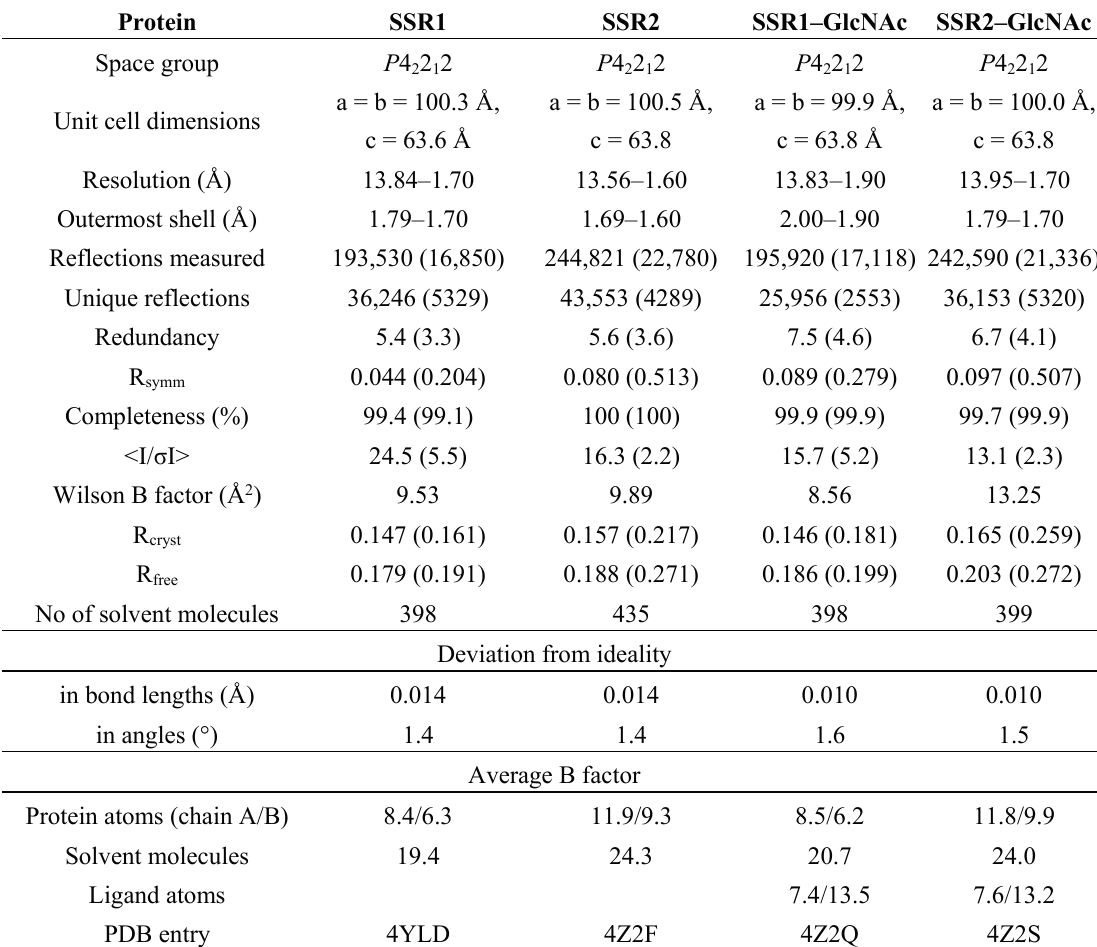
Table 7. Summary of the diffraction data processing and refinement statistics. Values in parentheses are for the outermost